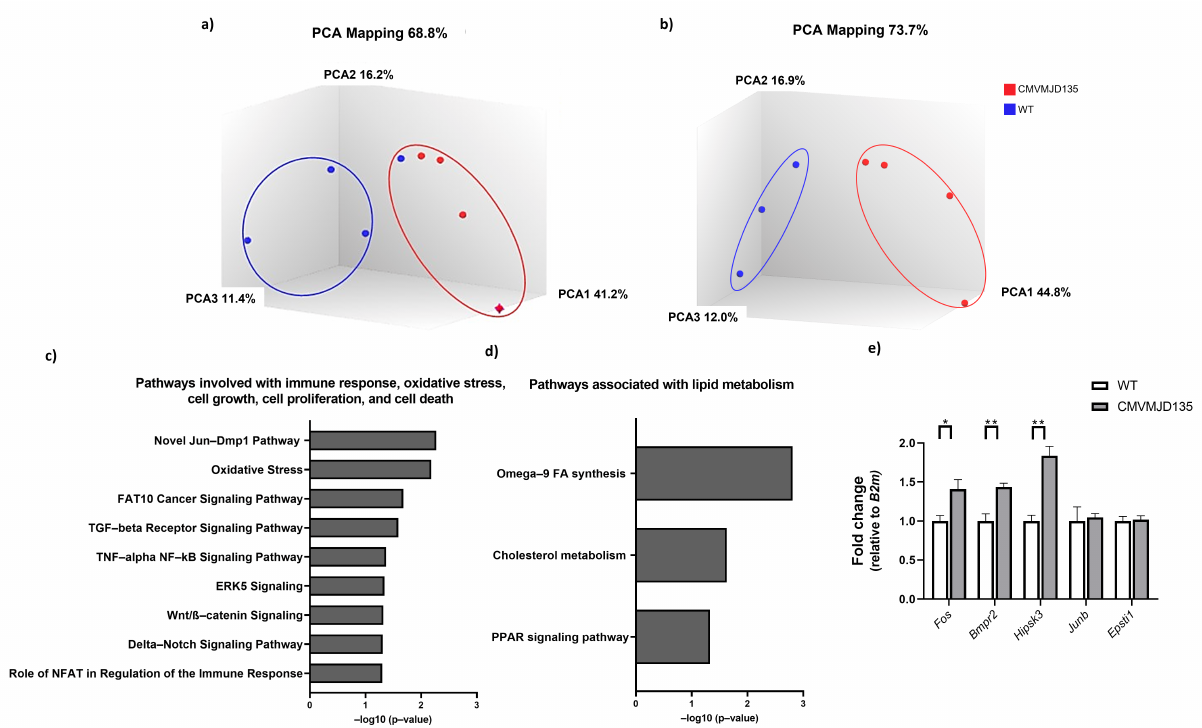
Figure 7. Up-regulated differentially expressed genes (DEGs) found in CMVMJD135-derived mi- croglia are associated with immune response, oxidative stress, cell growth, cell proliferation, cell death, and lipid metabolism pathways. Before the analysis of the DEGs, and of the molecular path- ways altered, a principal components analysis (PCA) was conceived to evaluate if CMVMJD135 and WT mice showed distinct profiles. ( a ) The PCA sets one WT sample within the vicinity of the CMVMJD135 cluster. WT cluster presents a sparser configuration. ( b ) PCA shows a clear expression separation between CMVMJD135 and WT without sample WT1. WT cluster presents a denser con- figuration. Three biological replicates for WT mice and four biological replicates for CMVMJD135 mice. Pathways significantly altered were found in microglia from CMVMJD135 mice compared with WT mice. ( c ) Pathways associated with immune response, oxidative stress, cell growth, cell proliferation, and cell death. ( d ) Pathways associated with lipid metabolism. All pathways are presented in descending order of significance. ( e ) Expression analysis performed on the selected genes confirmed the results obtained from RNA-sequencing analysis of microglia. An increase in the expression of Fos , Bmpr2 , and Hipsk3 was found in microglia from CMVMJD135 mice. n = 3–4 per group, and two technical replicates were performed. Fold change (2 − ∆∆ CT ) is represented using B2m as a housekeeping gene. Data are presented as mean + SEM (Student’s t -test). *, **, represent p < 0.05 and p < 0.01,